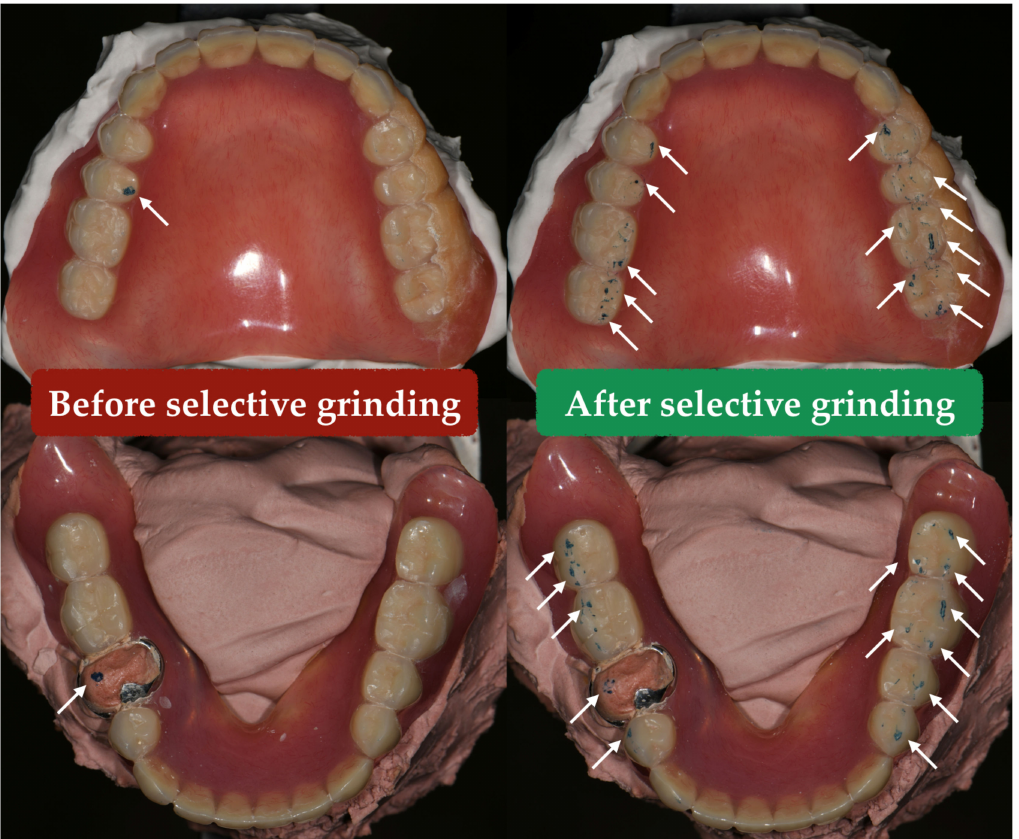
Figure 4. At the centric relation position, there was premature contact (white arrow) before selective grinding. After adjustment, the balanced occlusal scheme was achieved (white